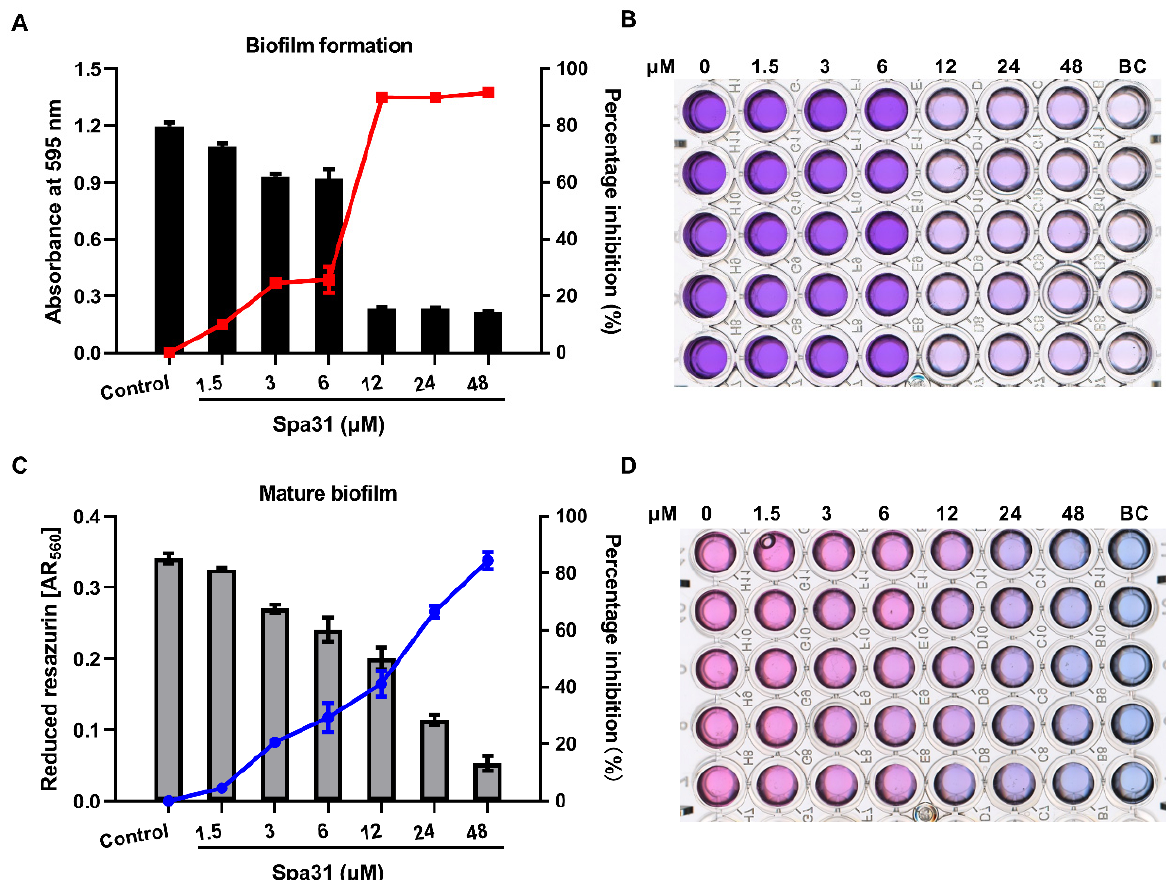
Figure 7. Anti-biofilm activity of Spa31 against P. aeruginosa . The inhibitory effect of Spa31 on biofilm formation ( A , B ) or mature biofilm ( C , D ) of P. aeruginosa .